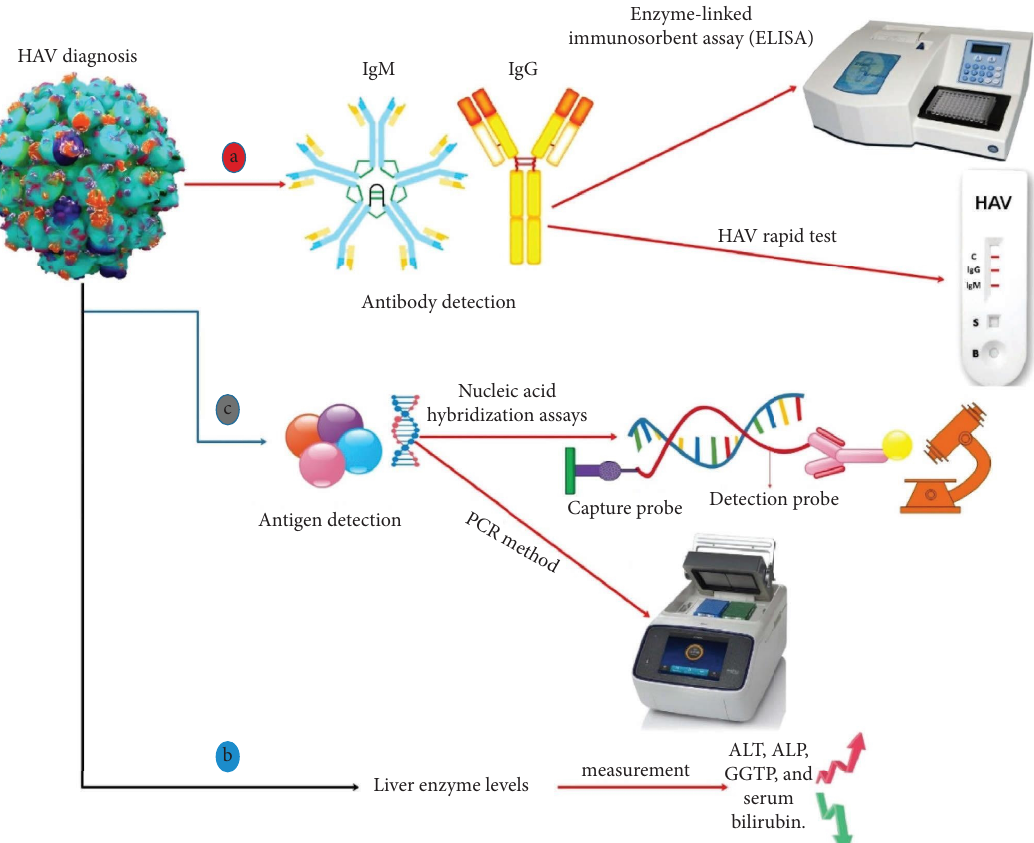
Figure 3: Diferent methods can be used to diagnose HAV infection, such as (a) specifc diagnosis based on antibody detection: IgM antibodies are presented in the early stages, whereas IgG antibodies can persist for up to 6months after infection. ELISA and immunochromatographic-based assays are used to diferentiate between antibodies. Additional tests include (b) checking the level of liver enzymes and serum bilirubin and (c) molecular methods such as PCR to detect the virus